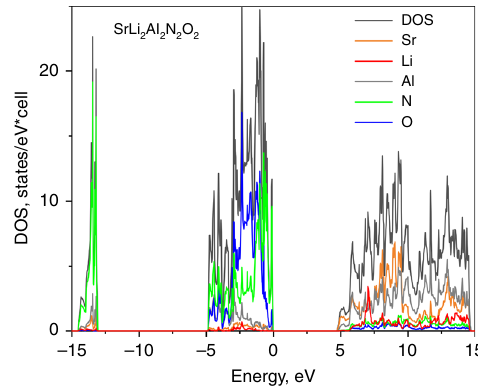
Fig. 3 Projected total density of states (DOS) obtained from Linear combination of atomic orbitals and atom-resolved partial electronic density-of-states (pDOS) of SALON. The energy zero is taken at the Fermi